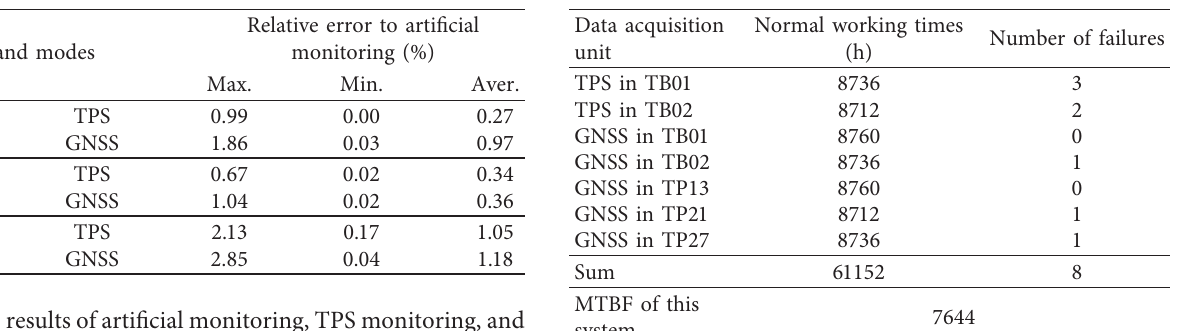
Table 4: The mean time between failures of the acquisition units in the Pubugou